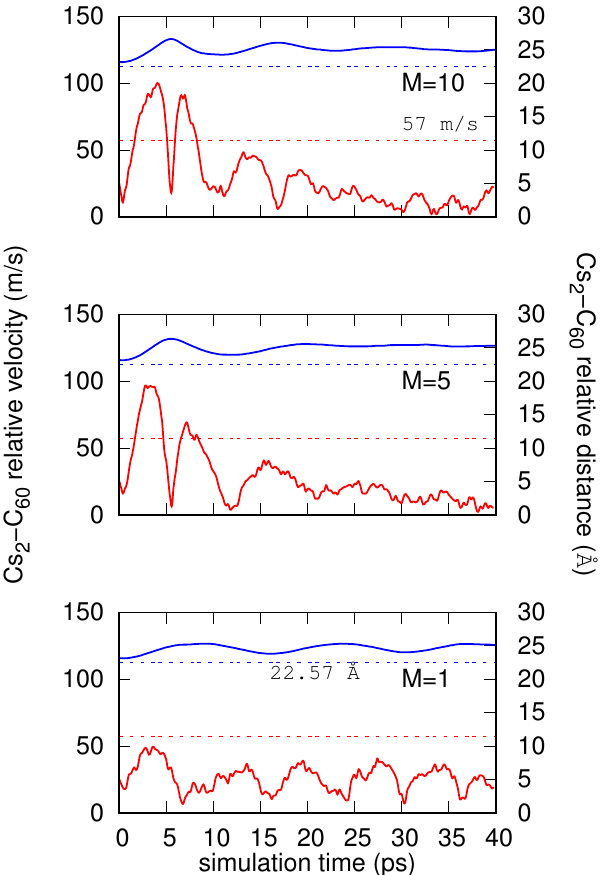
Figure 6. Evolution of relative Cs 2 -C 60 distance (blue solid lines, right vertical axis) and velocity (red solid lines, left vertical axis) as a function of time. It was obtained through PIMD simulations for number M of beads considered, with common initial relative velocity being v 0 = 25.4 m/s. Constant dashed lines indicate the critical Landau velocity (shown in red) as well as the crossing distance between neutral and ionic potential energy curves at initial T-shaped orientation (shown in